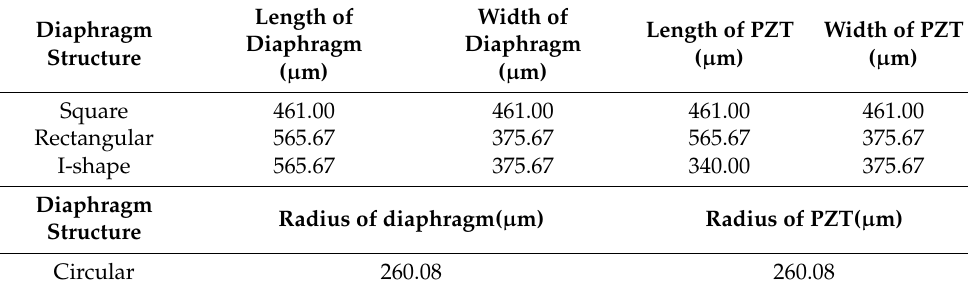
Table 1. Structure parameters of four types of the composite